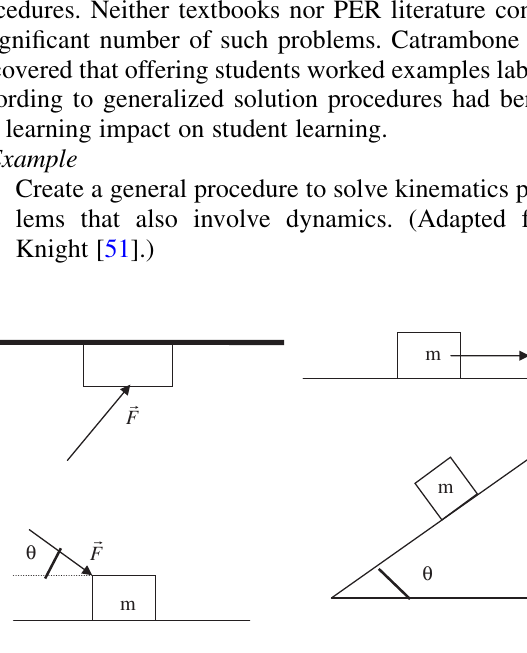
FIG. 5. Objects in equilibrium on surfaces with